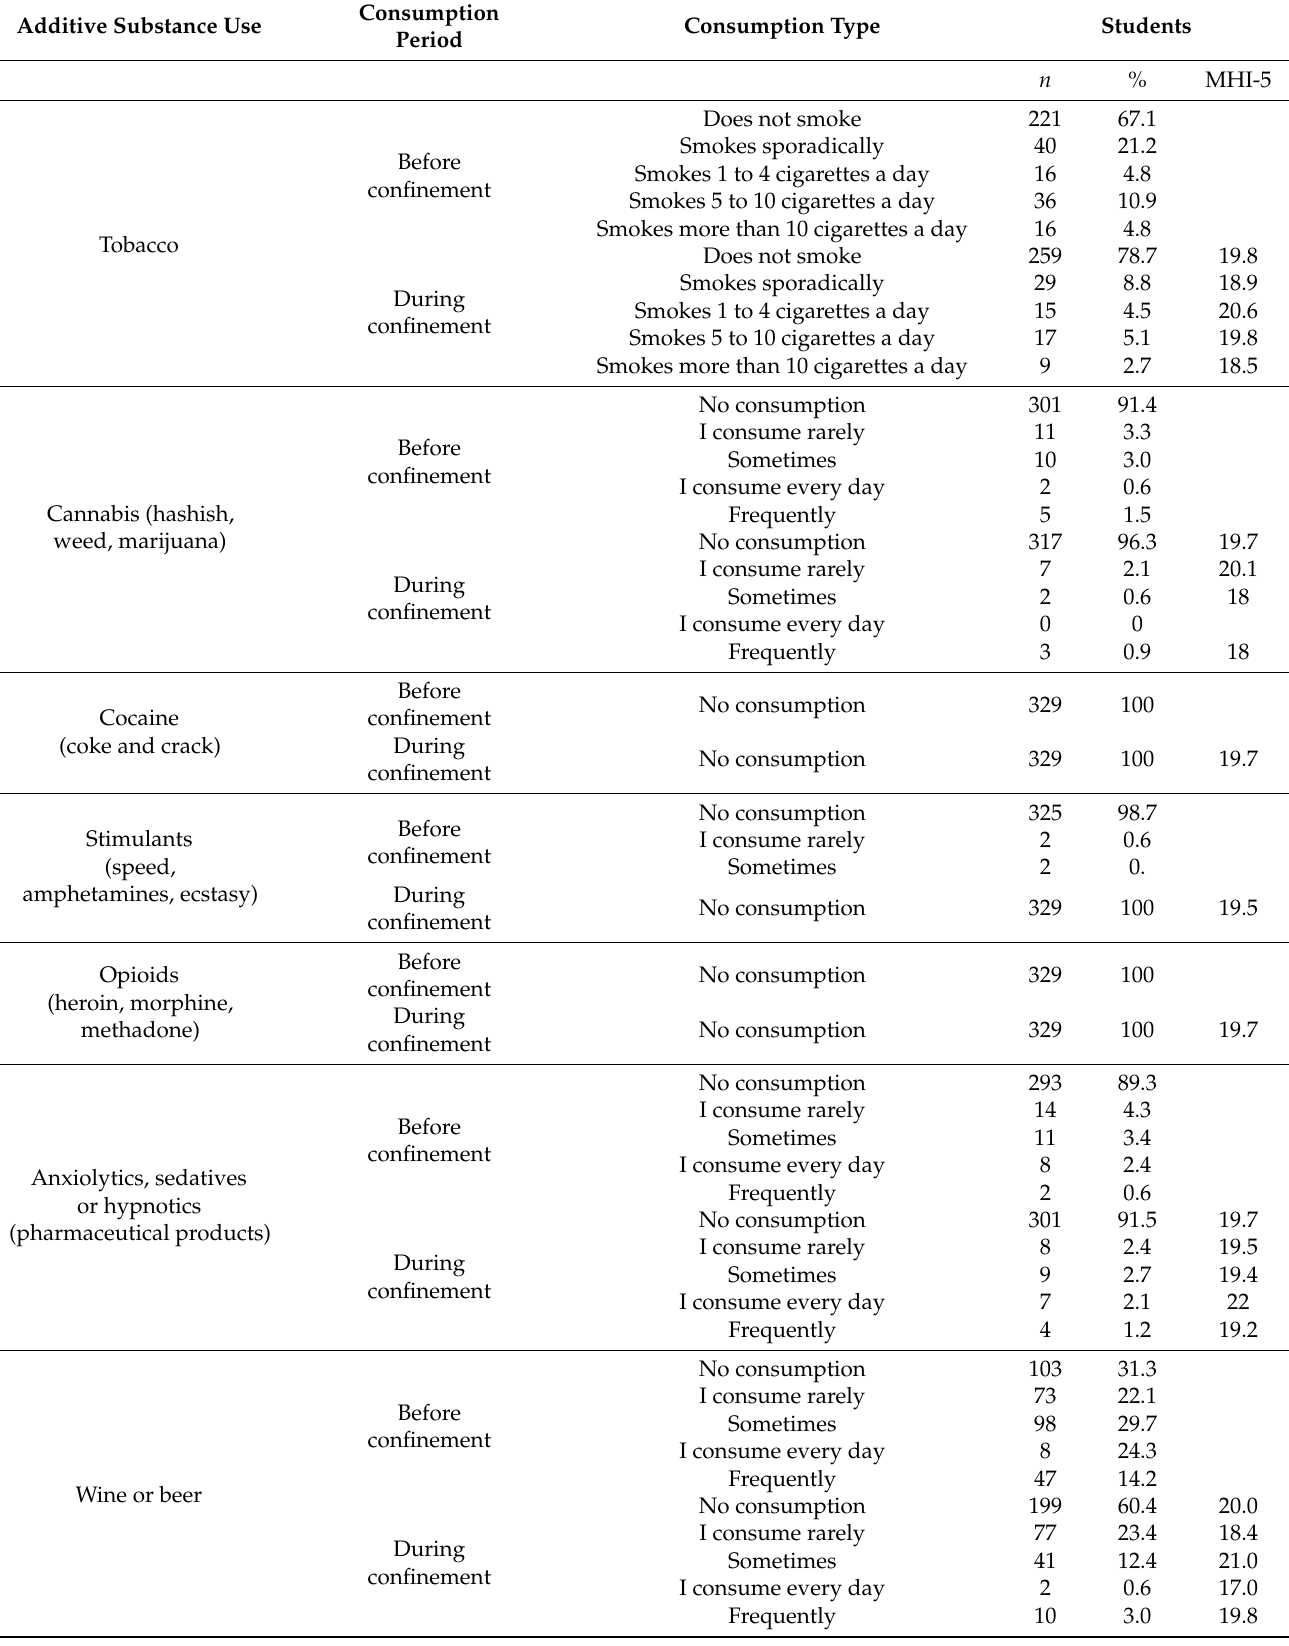
Table 1. Addictive substance use before and during confinement, and mental health during